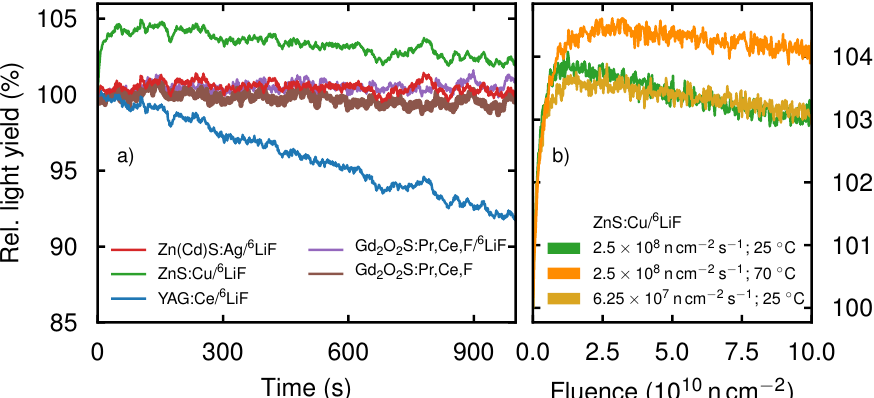
Figure 2. ( a ) Time-dependent light yield of the five scintillation screens during the first 1000s of neutron irradiation relative to their respective light yield at time t i = 0s. ( b ) Change of the fluence-dependent light yield of ZnS upon change of the neutron flux or the temperature of the scintillation screen, respectively. The curves were adjusted for time-dependent neutron flux variations and normalized to the respective light yield at t i =